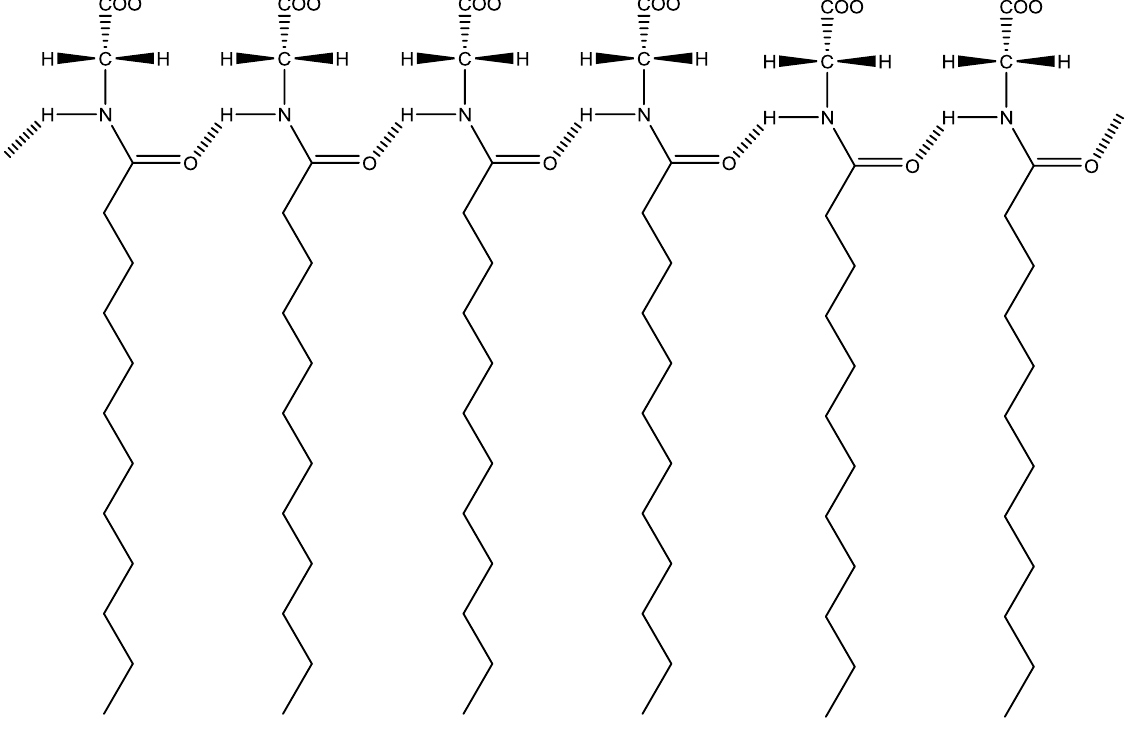
SO /1-tridecanol (TDeOH)/water 2 4 at 40.0 °C after 1 h; ( b ) N to N phase D D B at 23.00 °C; ( d ) laboratory reference frame. P , A and C